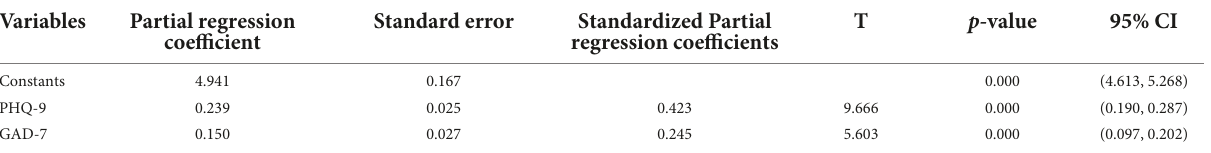
TABLE 5 Fitting results of multiple linear regression